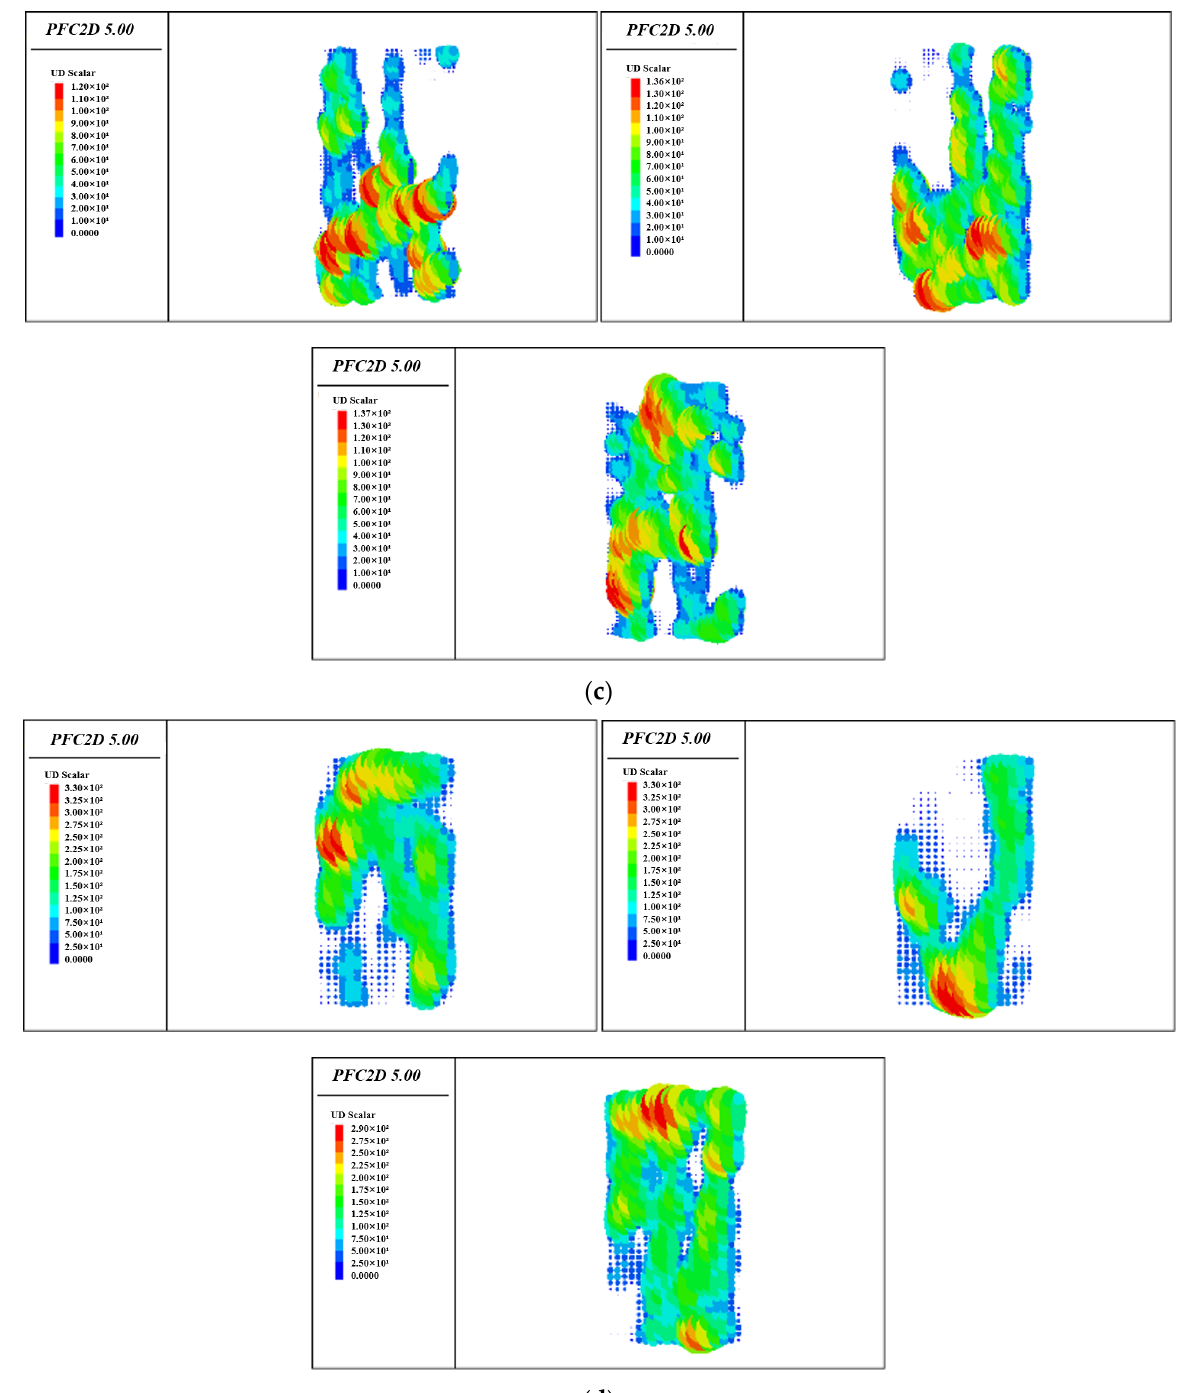
Figure 17. Hot spot diagram of crack distribution: ( a ) One layer; ( b ) Two layers; ( c ) Three layers; ( d ) Four layers.